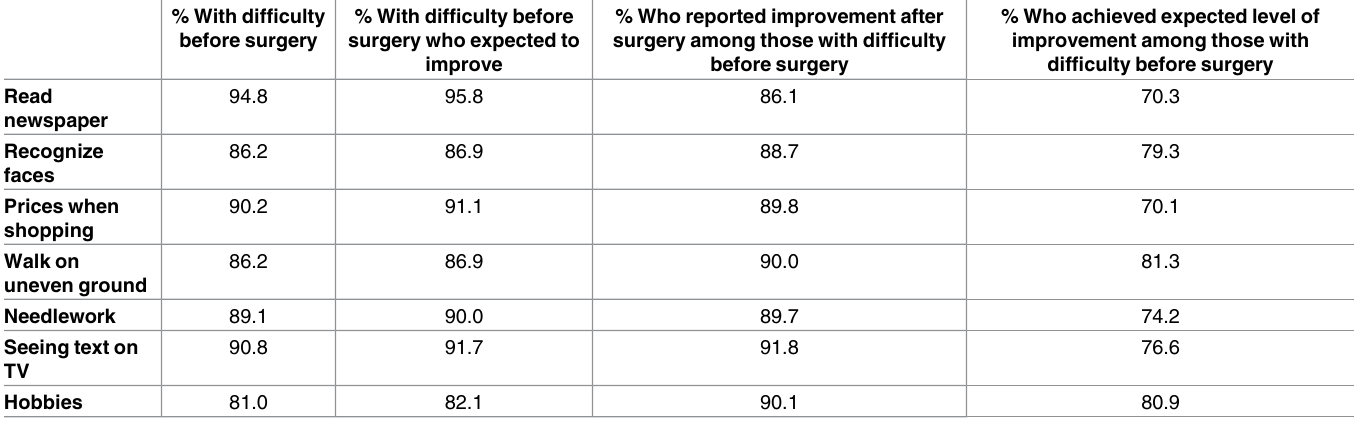
Table 5. Expected and actual improvement in activities on the Catquest-9SF items (N =